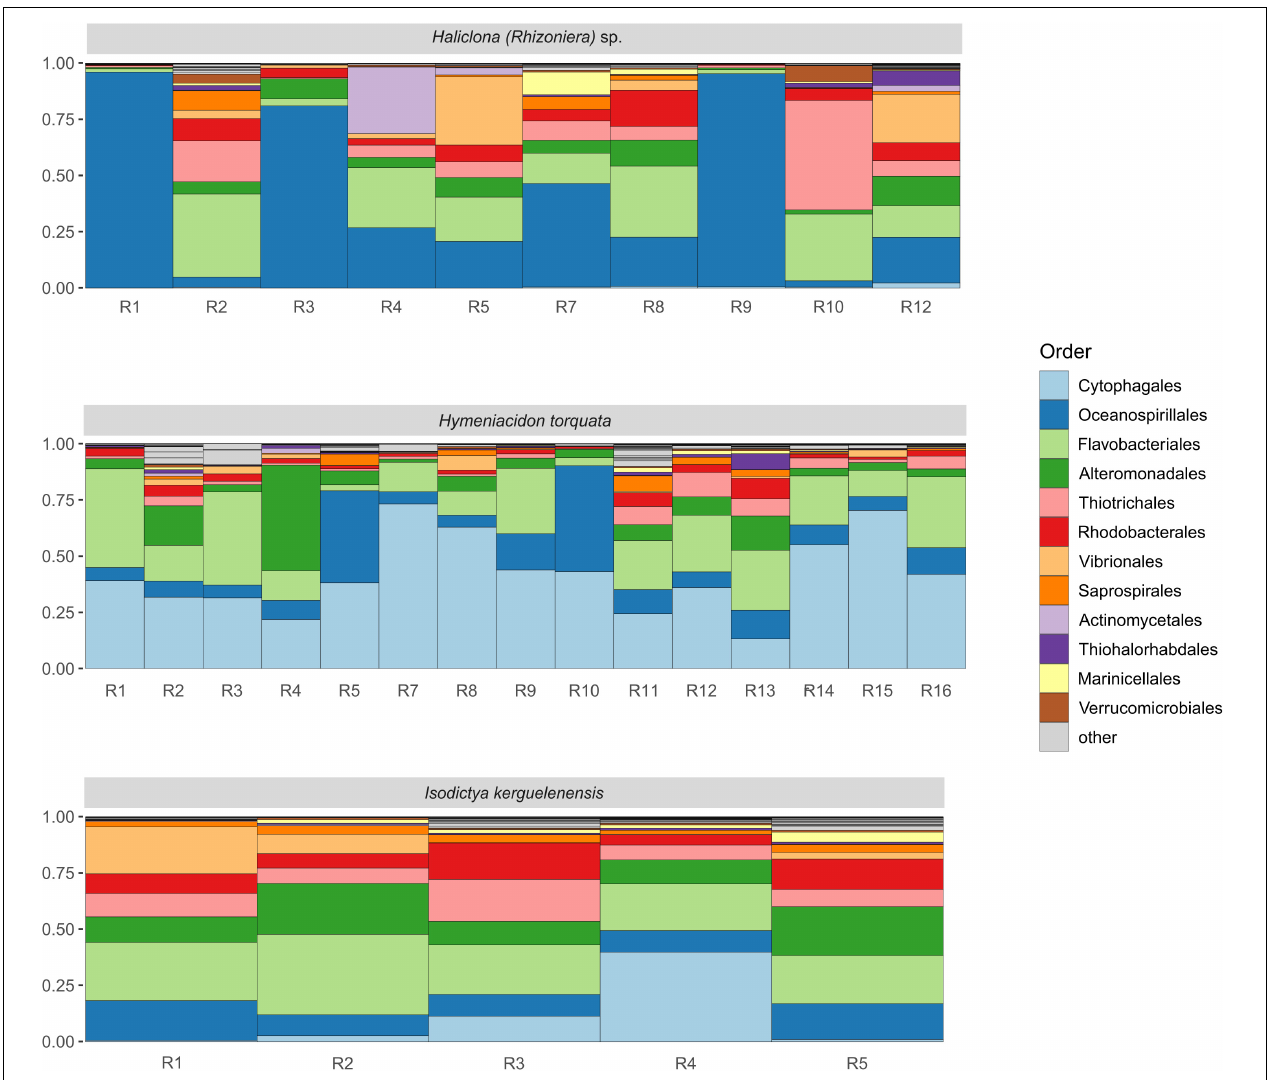
FIGURE 2 | Bacterial composition of the microbiome of the Antarctic sponges Haliclona (Rhizoniera) sp., Hymeniacidon torquata , and Isodictya kerguelenensis , at order level. R followed by a number represents the individual from each sponge species. The color legend shows the 12 most abundant bacterial orders.